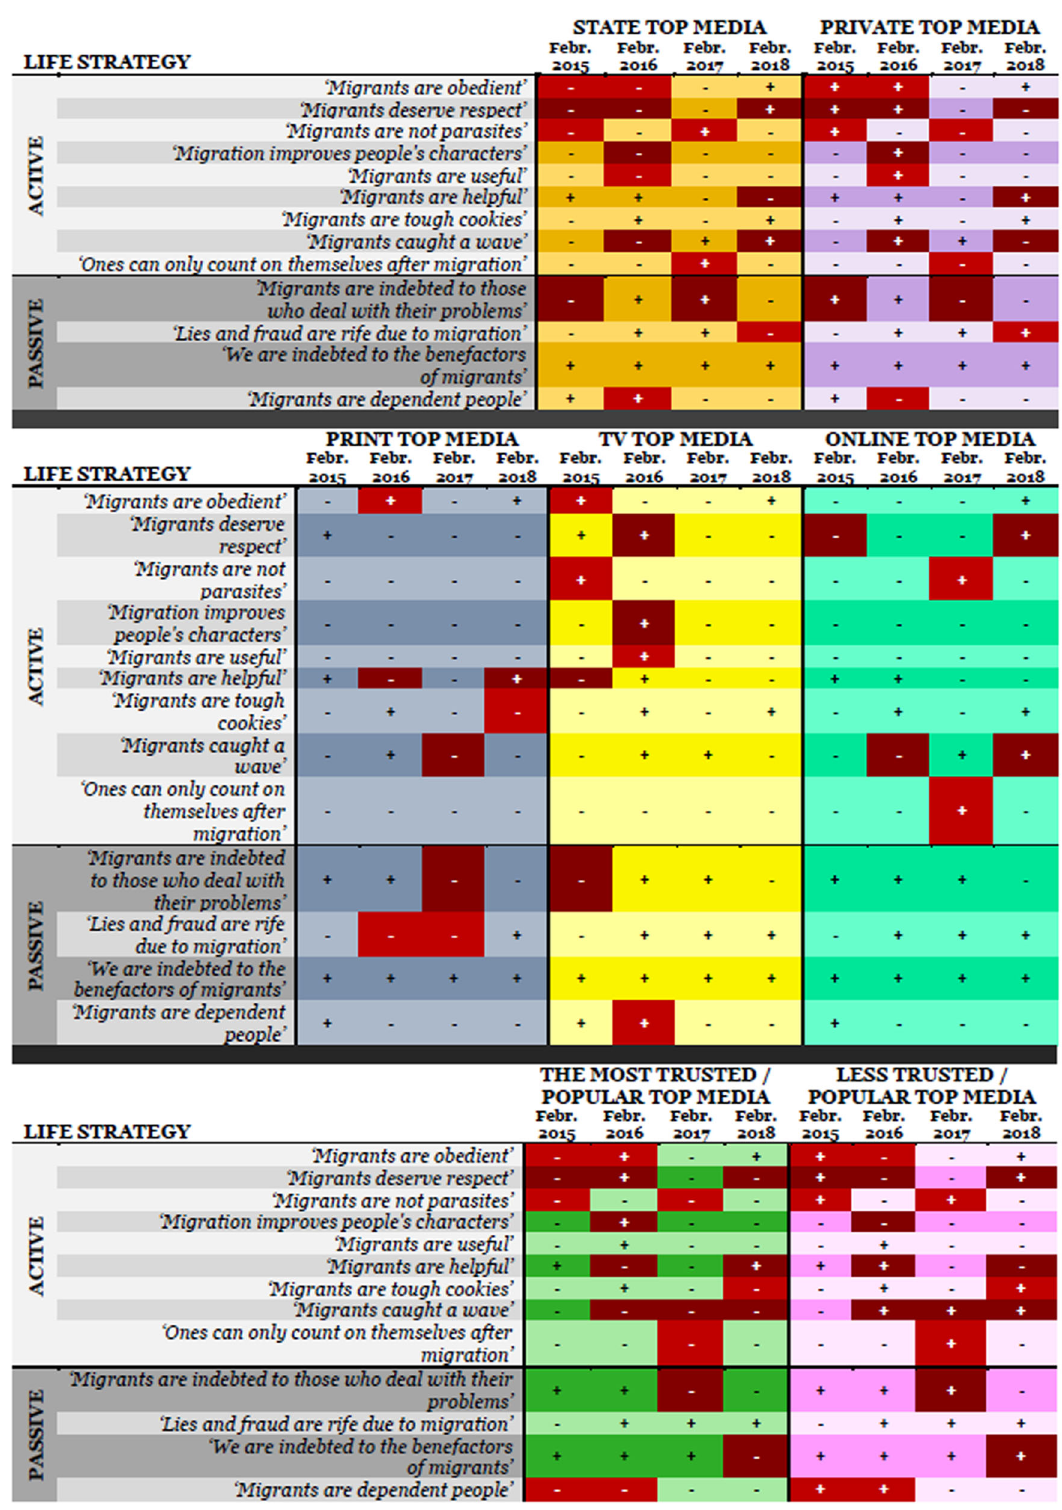
Fig. 4 Life strategy hidden issues related to migration and migrants in different types of Ukrainian top media (2015 – 2018, sample from every February messages). Source: A. Tashchenko ’ s elaboration based on qualitative content analysis (by L. Yuzva and A. Tashchenko), analysis of discourse positions and sociocognitive critical discourse analysis (by A. Tashchenko) of media messages. Data source: The Center for Content Analysis research based on quantitative media content analysis, 2019. The comparative illustration demonstrates the dynamics of dissimilarity (highlighted in dark red) of different implications ’ emergence: ‘ + ’ indicates the presence of implication, ‘ - ’ indicates the absence of implication. All other colors are used to delimit areas for the sake of visual convenience.